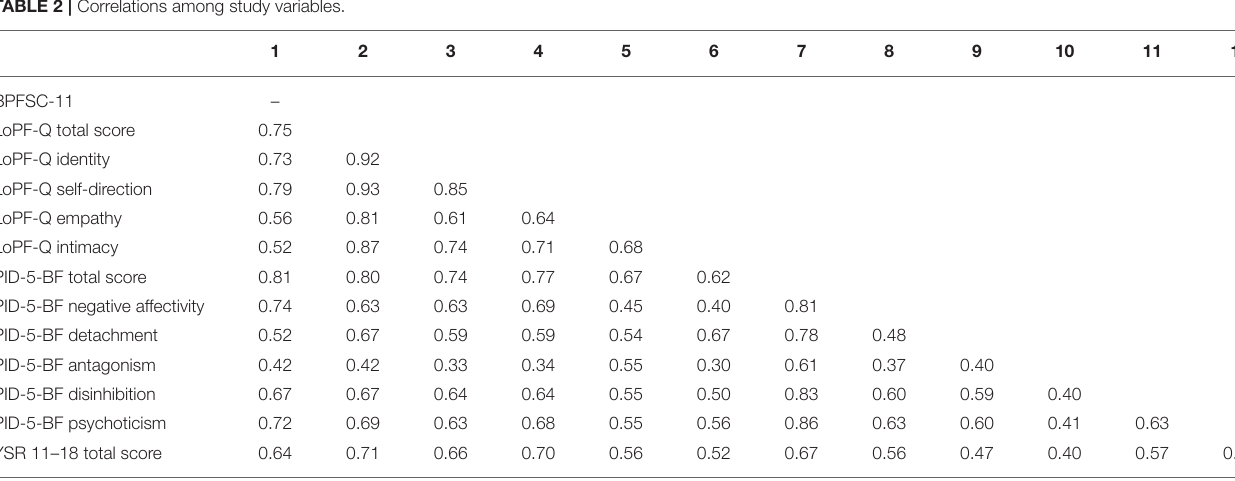
TABLE 2 | Correlations among study